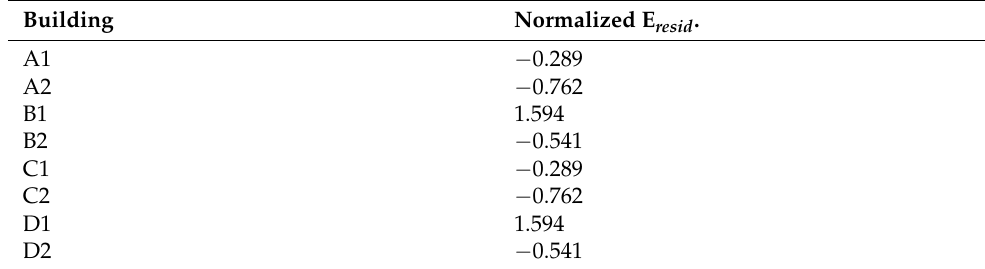
Table 4. Normalized data of Table